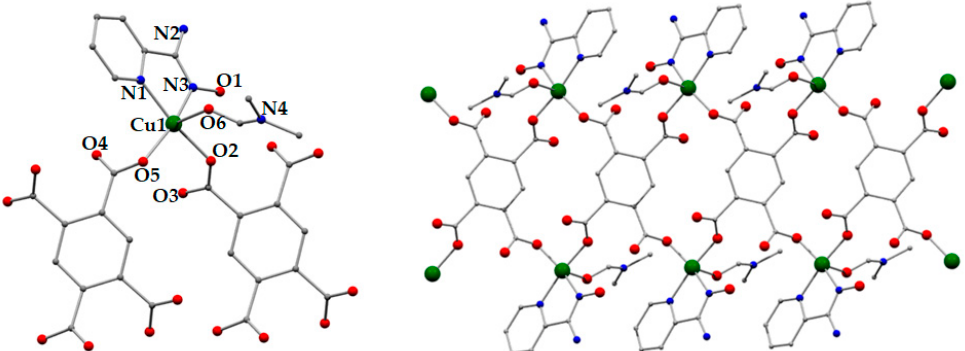
Figure 5. Representation of the repeating unit ( left ) and a part of the double 1D chain of 6 ( right ). Color code: Cu, blue; N, navy blue; O, red; C, grey. The hydrogens are omitted for